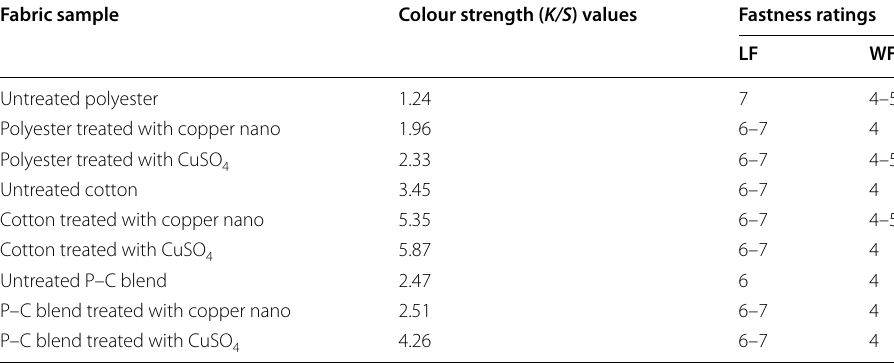
K/S Colour Strength value , LF Light Fastness , WF Washing Fastness